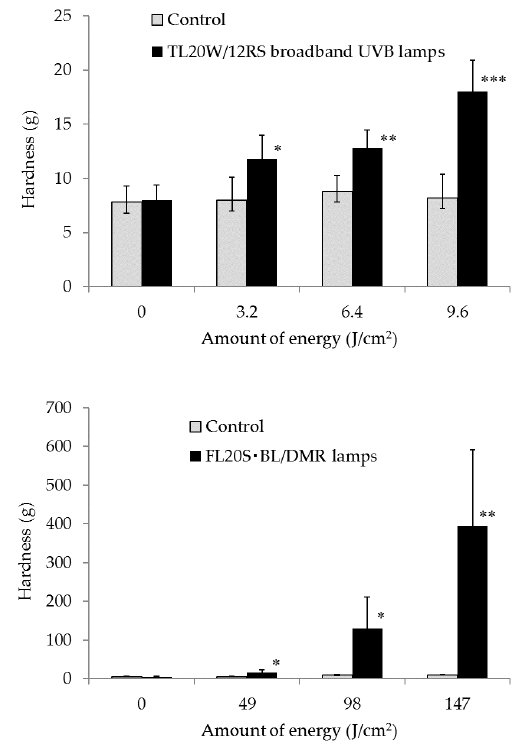
Figure 5. Change in hardness of collagen gels irradiated with either UVB lamps or UVA lamps measured by the Rheo TEX SD-700. n = 6, Mean ± S.D., * p < 0.05 vs. 0 J/cm 2 , ** p < 0.01 vs. 0 J/cm 2 , *** p < 0.001 vs. 0 J/cm 2 .